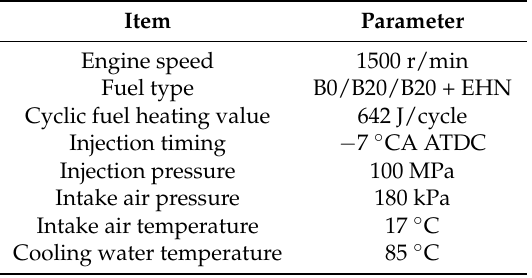
Table 4. Test conditions of